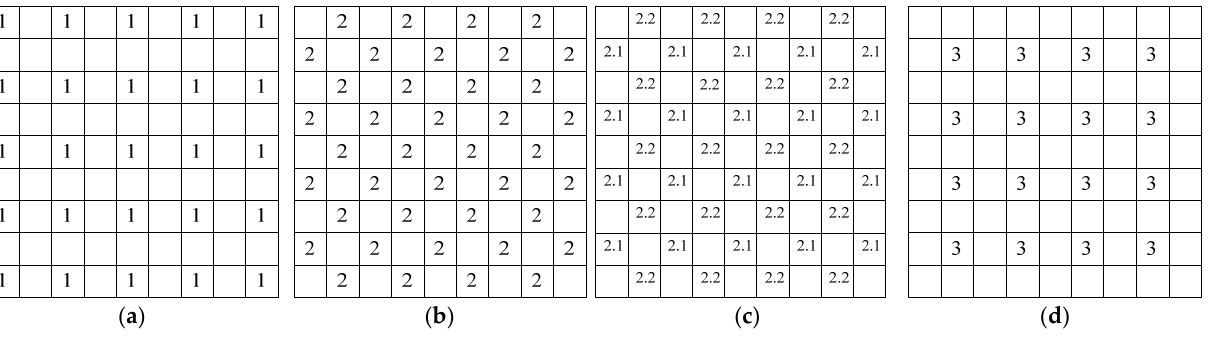
Figure 3. Pixel classification. ( a ) Pixels of group one; ( b ) Pixels of group two; ( c ) Subgroups for group two; ( d ) Pixels of group three.